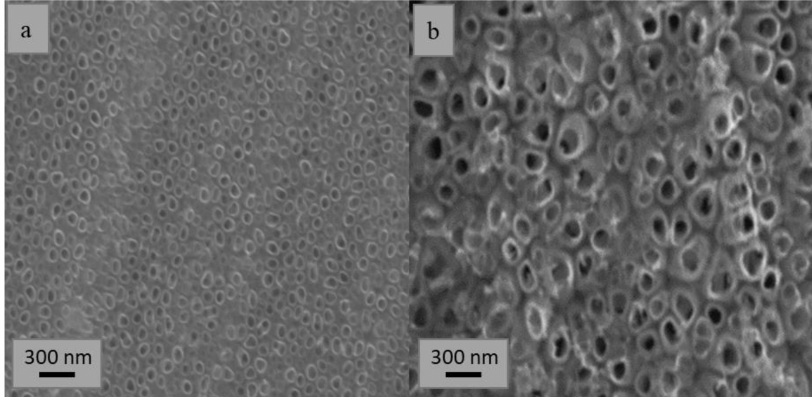
Figure 2. SEM images of the top-view of the samples prepared by anodic oxidation ( a ) TNT; ( b )